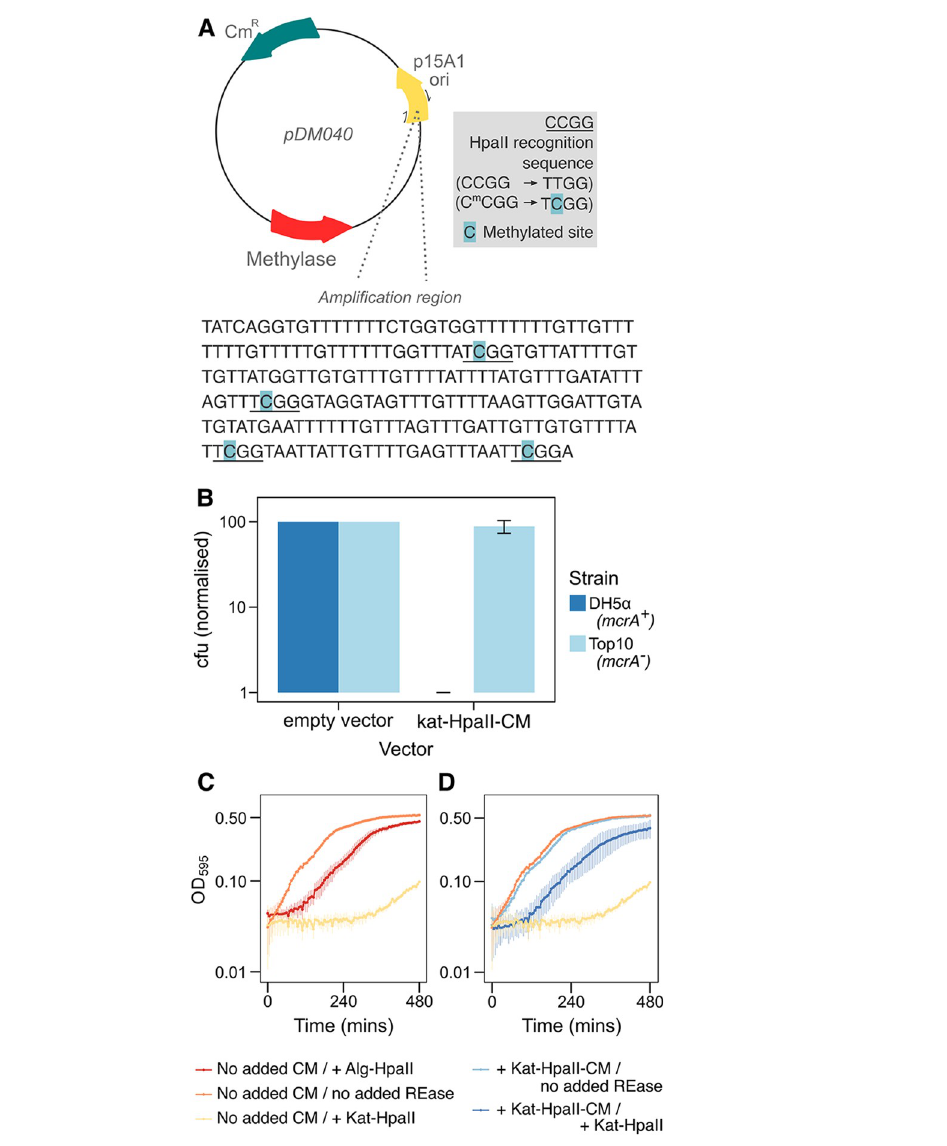
Fig 3. Heterologously expressed katablepharid HpaII-CM and HpaII are catalytically active. (A) Bisulfite conversion to identify 5-methylcytosine modification by the katablepharid HpaII-CM. Schematic of bisulfite conversion protocol to assess 5-methylcytosine modifications. Plasmids were purified from E . coli Top10 and subjected to bisulfite conversion to convert cytosine to uracil (replaced with thymine during PCR), while 5-methylcytosines (5-mC) remain unaffected. Moreover, 5-mC residues were detected within the amplification region when the katablepharid HpaII-CM was present on plasmid pDM040. Notably, each methylated site (indicated in blue) was located at CCGG, an HpaII recognition sequence (underlined). (B) Transformation efficiency of E . coli strains when transformed with putative katablepharid HpaII-CM. Transformation efficiency of E . coli DH5 α and Top10 strains when transformed with empty vector control (pACYC184) or vector containing the katablepharid putative methyltransferase coding sequence (pDM40). Experiments were performed from a minimum of three independent competent cell batches, and CFUs were enumerated and normalised to the positive control (pACYC184) within each batch. These data demonstrate that the katablepharid HpaII methyltransferase is toxic in E . coli DH5 α ( mcrA +), but not in Top10 ( mcrA -). Error bars represent one standard deviation from the mean. Underlying data in S3 Data . (C) Growth of E . coli Top10 cells with combinations of plasmids containing putative katablepharid methyltransferase (CM +), katablepharid HpaII ( Kat HpaII), and Algibacter HpaII ( Alg HpaII) genes or the corresponding empty vectors (“no added CM” or “no added REase” [restriction endonuclease]). Duplicate cultures from independent transformants were grown for eight hours under Amp/Cm selection, induced with 0.0004% arabinose, at 37˚C, and growth was assessed by measuring OD 595 at five-minute intervals. The strain lacking the endonuclease showed typical E . coli growth, while addition of either the Algibacter ( Alg ) endonuclease or Katablepharid ( Kat ) endonuclease to the strain lacking